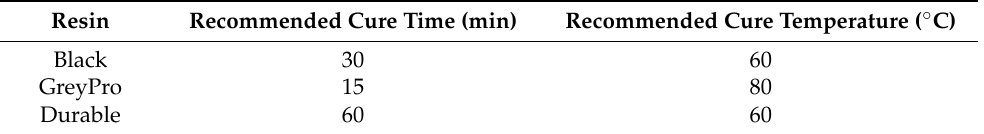
Table 3. Recommended UV-cure for parts printed with Black, GreyPro and Durable resins (Formlabs, Somerville, MA,